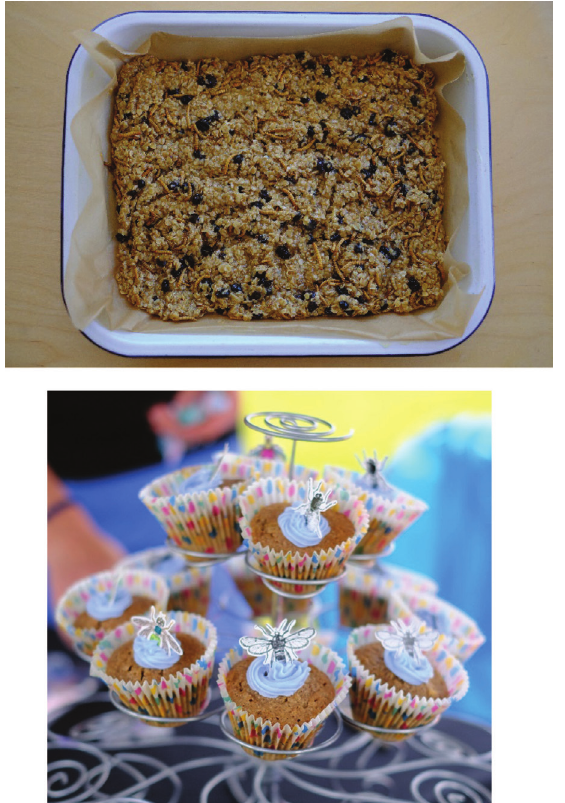
Figure 2: Photographs from the event showing how the foods made with insect ingredients were presented